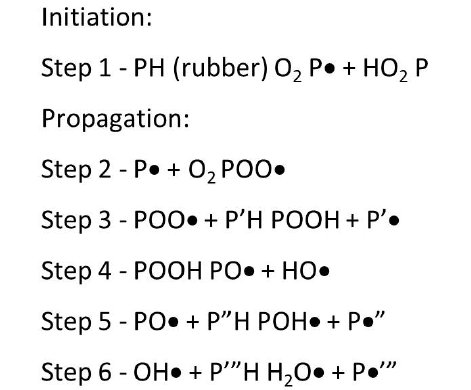
Figure 1. Illustrative scheme of the degradation reaction in an elastomeric matrix 7